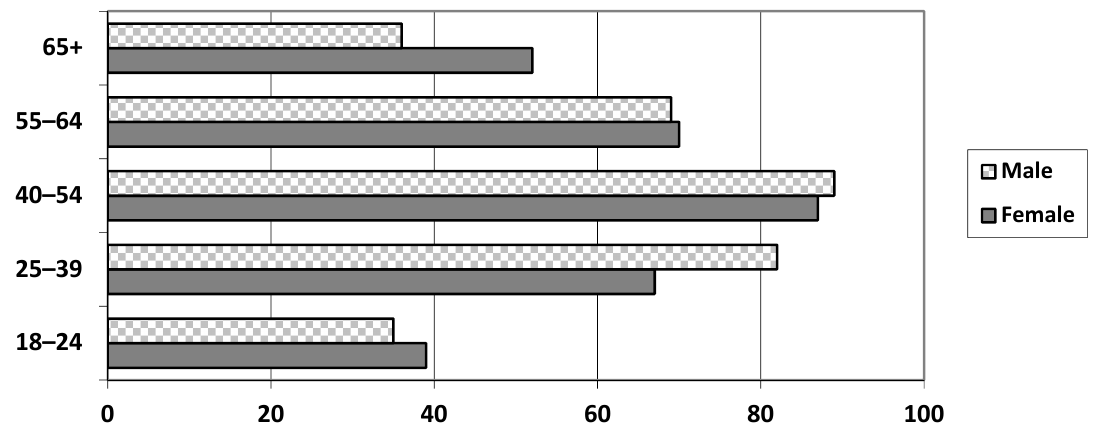
Figure 1. Distribution of respondents by gender and by age group .